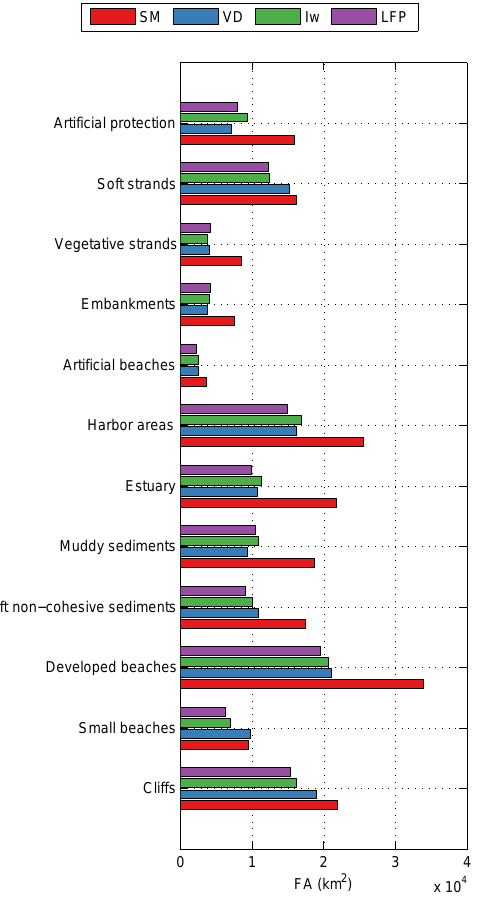
Figure 7. Comparison of the flooded area (FA) for the present-day 100-year event aggregated per coastline type for all four inunda- tion approaches. Values correspond to km 2 per km; colors express the different inundation approaches (see legend) and horizontal bar stacks denote the shoreline